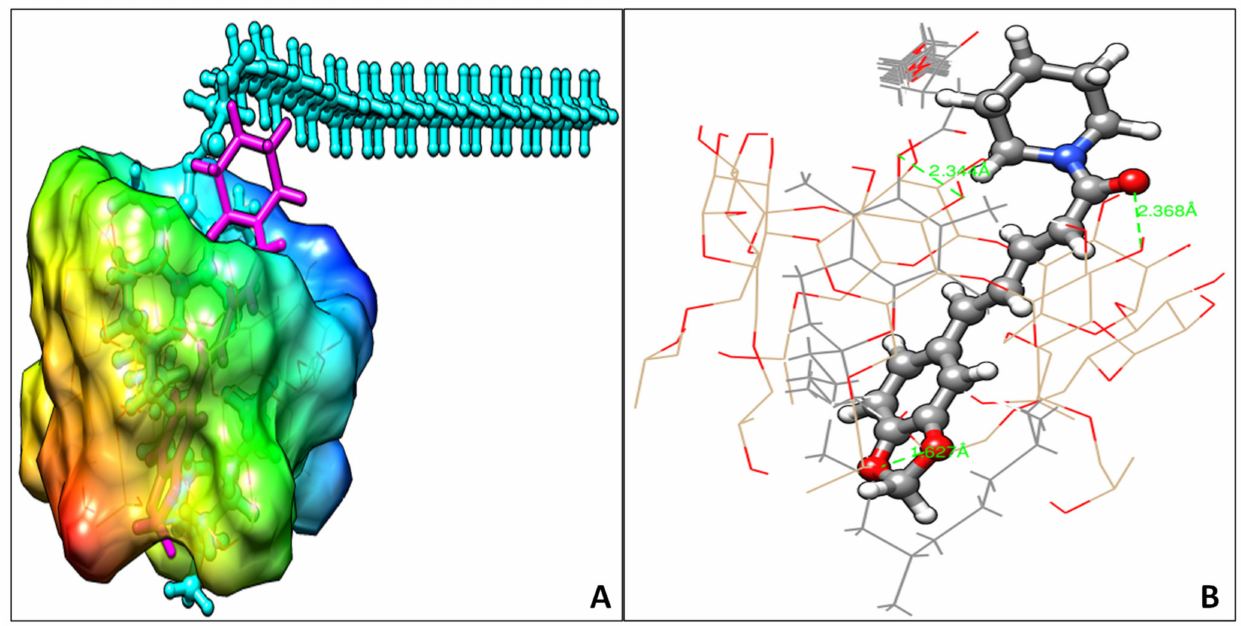
Figure 11. ( A ) The side binding poses of the ternary inclusion complex piperine (magenta), HP β CD (surface view), and TPGS (cyan), ( B ) binding mode of PIP (ball and stick), TPGS (stick) at the central cavity of HP β CD (wire). Piperine formed two hydrogen bonds (green dotted lines) with 3-OH (2.36 Å) and hydroxy propyl (1.62 Å), whereas TPGS formed one hydrogen bond with 3-OH (2.34